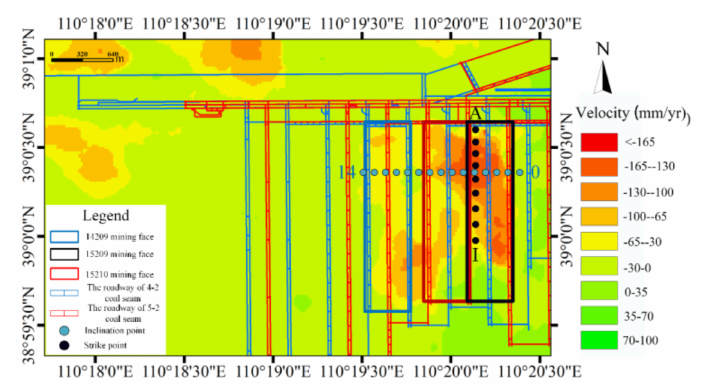
Figure 7. Location of the survey line points.